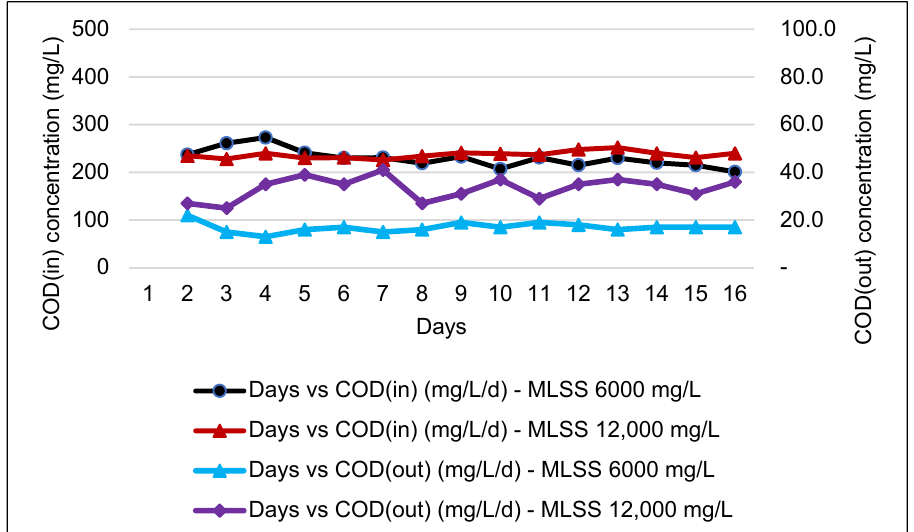
Figure 3. COD concentration of influent and effluent for an MBR system at MLSS values of 6000 mg/L and 12,000 mg/L by using an HF membrane.